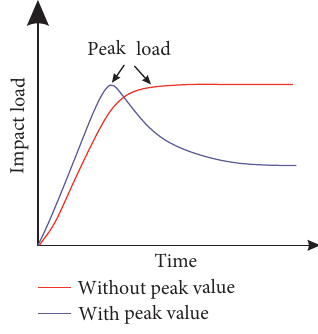
Figure 4: Time history of impact loaf.